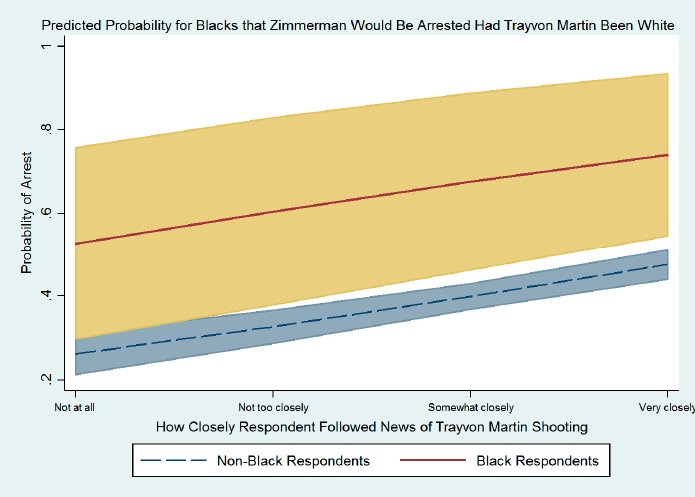
Figure 3. Perceptions of Injustice by Media Exposure among Blacks and Non-Blacks.